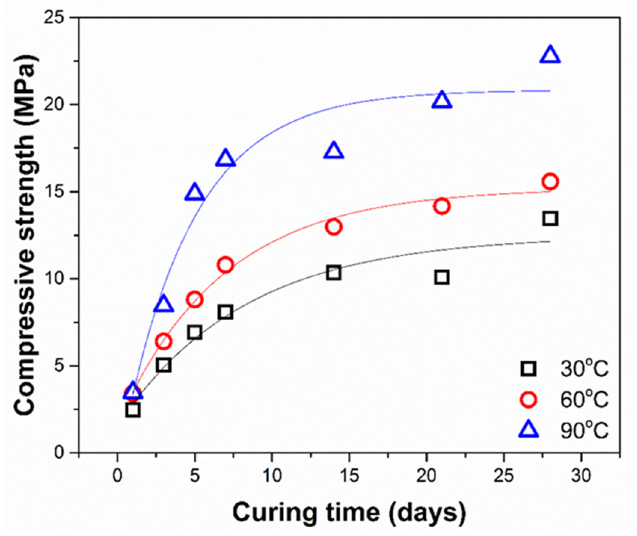
Figure 4. Compressive strength of geopolymer mortars cured at different